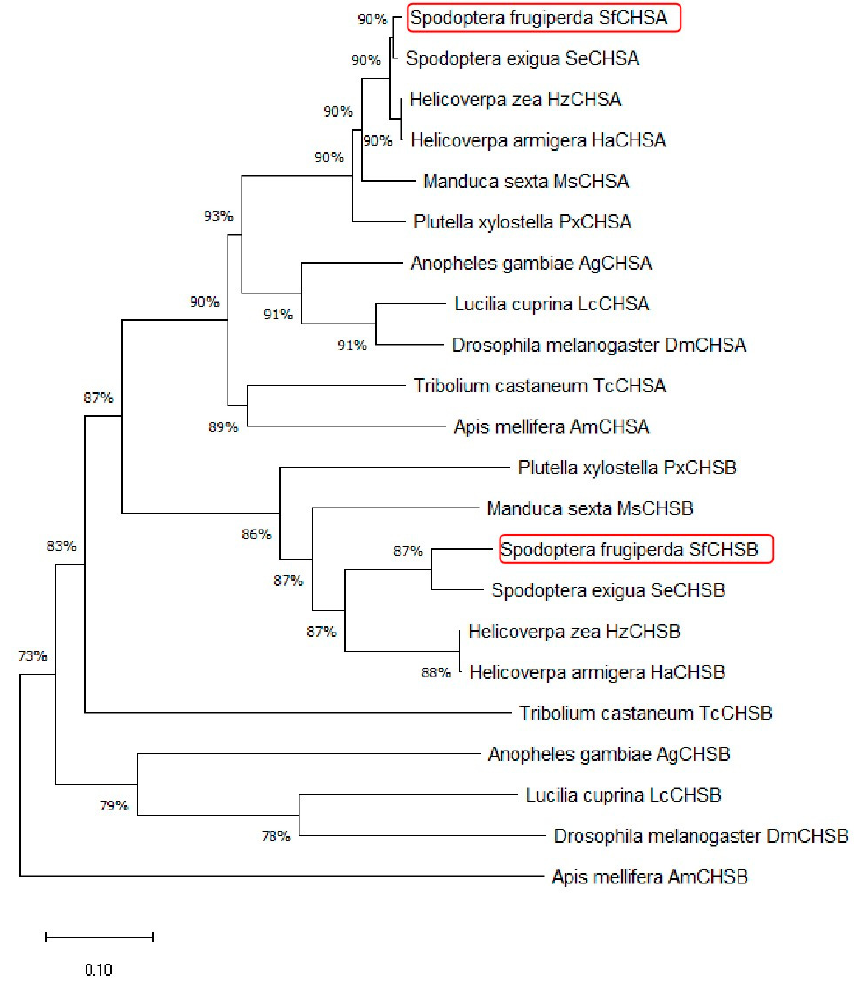
Figure 1. Phylogenetic tree based on the amino acid sequences of insect chitin synthases. The red border indicates the chitin synthase of S. frugiperda .